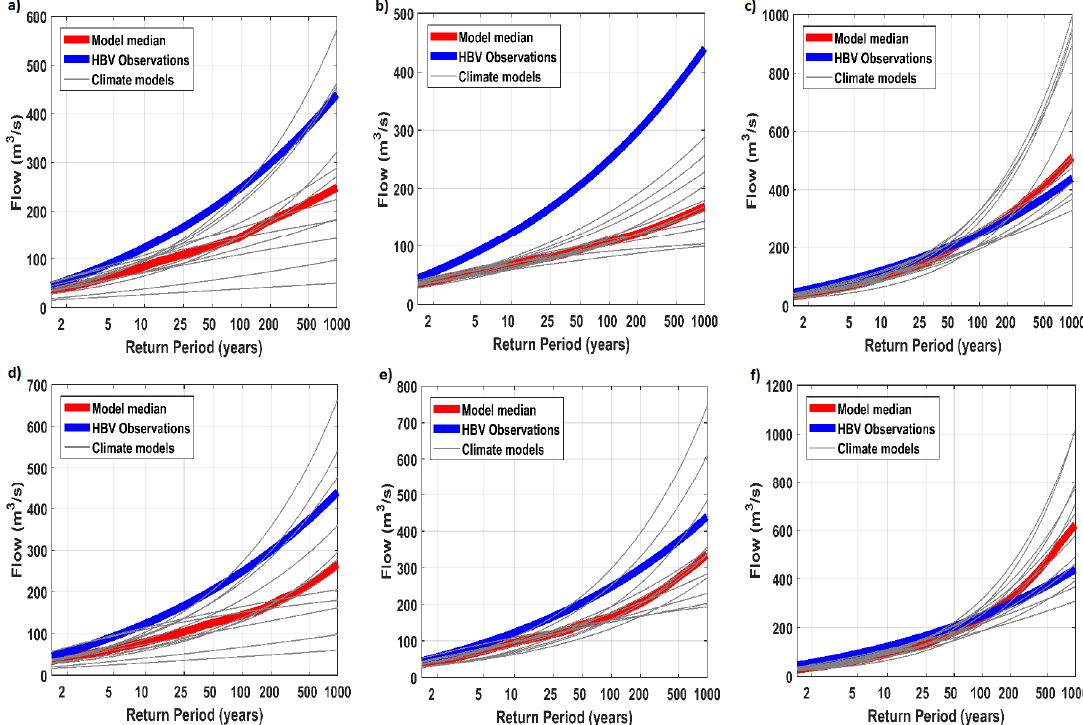
Figure 9. Comparison between flood frequency curves fitted to annual maximum series simulated by the HBV model with observed data and HBV simulations with climate projections in Camporredondo catchment, using a set of combinations of bias correction techniques. Red lines represent the median of the 12 climate models considered. ( a ) Raw data with no bias correction; ( b ) raw temperature and precipitation with QM linear correction; ( c ) raw temperature and precipitation with QM polynomial correction; ( d ) raw precipitation and temperature bias corrected; ( e ) temperature bias corrected and precipitation with QM linear correction; ( f ) temperature bias corrected and precipitation with QM polynomial correction.